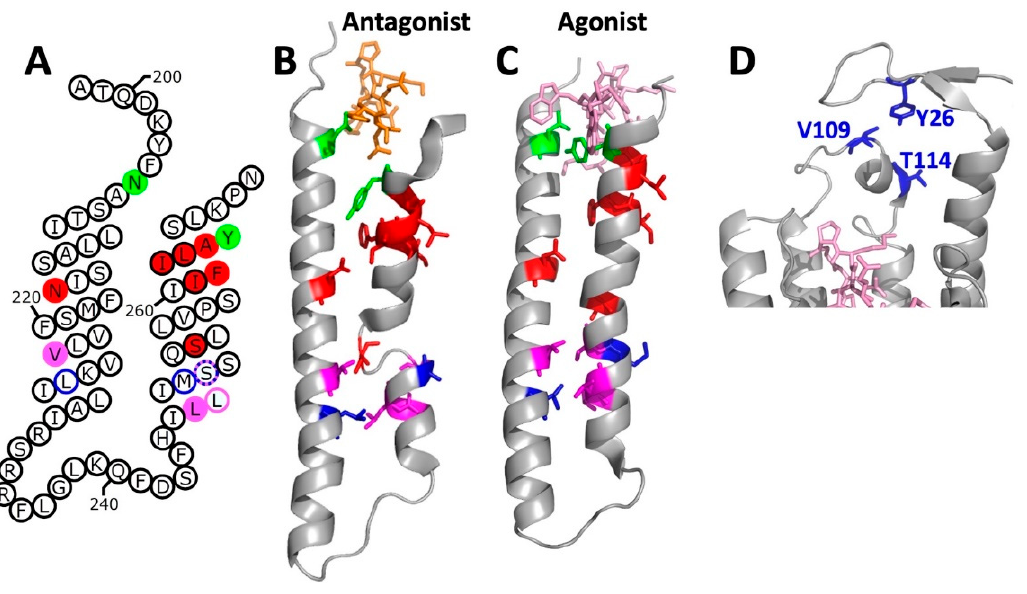
Figure 5. Locations of confirmed and putative disulfide crosslinks involving TM5 and TM6 (trans- membrane segments 5 and 6). ( A ) Interactions identified by Lee et al. [57] are shown in green, interactions identified by Dube et al. [58] are shown in magenta and blue, and interactions shown by Taslimi et al. [59] are shown in red. In each case, disulfides confirmed by peptide mapping are indicated by colored fills. Putative interactions identified based on constitutive activation that was dependent on the presence of cysteine at paired sites are indicated by a colored circle around the indicated residue. ( B ) Locations of putative crosslinks mapped onto the three-dimensional structures of TM5 and TM6 in the antagonist-bound receptor structure (PDB Code: 7QA8). Colors are as shown in (panel A ), but with no distinction between demonstrated functional and biochemically-confirmed interactions. Bound antagonist is shown in stick representation in orange. ( C ) Same as for (panel B ), but mapped onto TM5 and TM6 of the agonist-bound receptor G protein complex (PDB code: 7AD3). Note that the cysteine replacement at residue S251 shows functional interactions with cys- teines at the positions of either V223 or L226. This is indicated by alternating colored dashed circles in (panel A ), but the residue is only colored as magenta in (panels B and C ). Bound α -factor is shown in stick representation in pink. ( D ) Locations of putative crosslinks between cysteines substituted for Y26 in the N-terminal tail of Ste2p and for V109 and T114 in EC1. Relevant residues are shown in blue as stick representations.